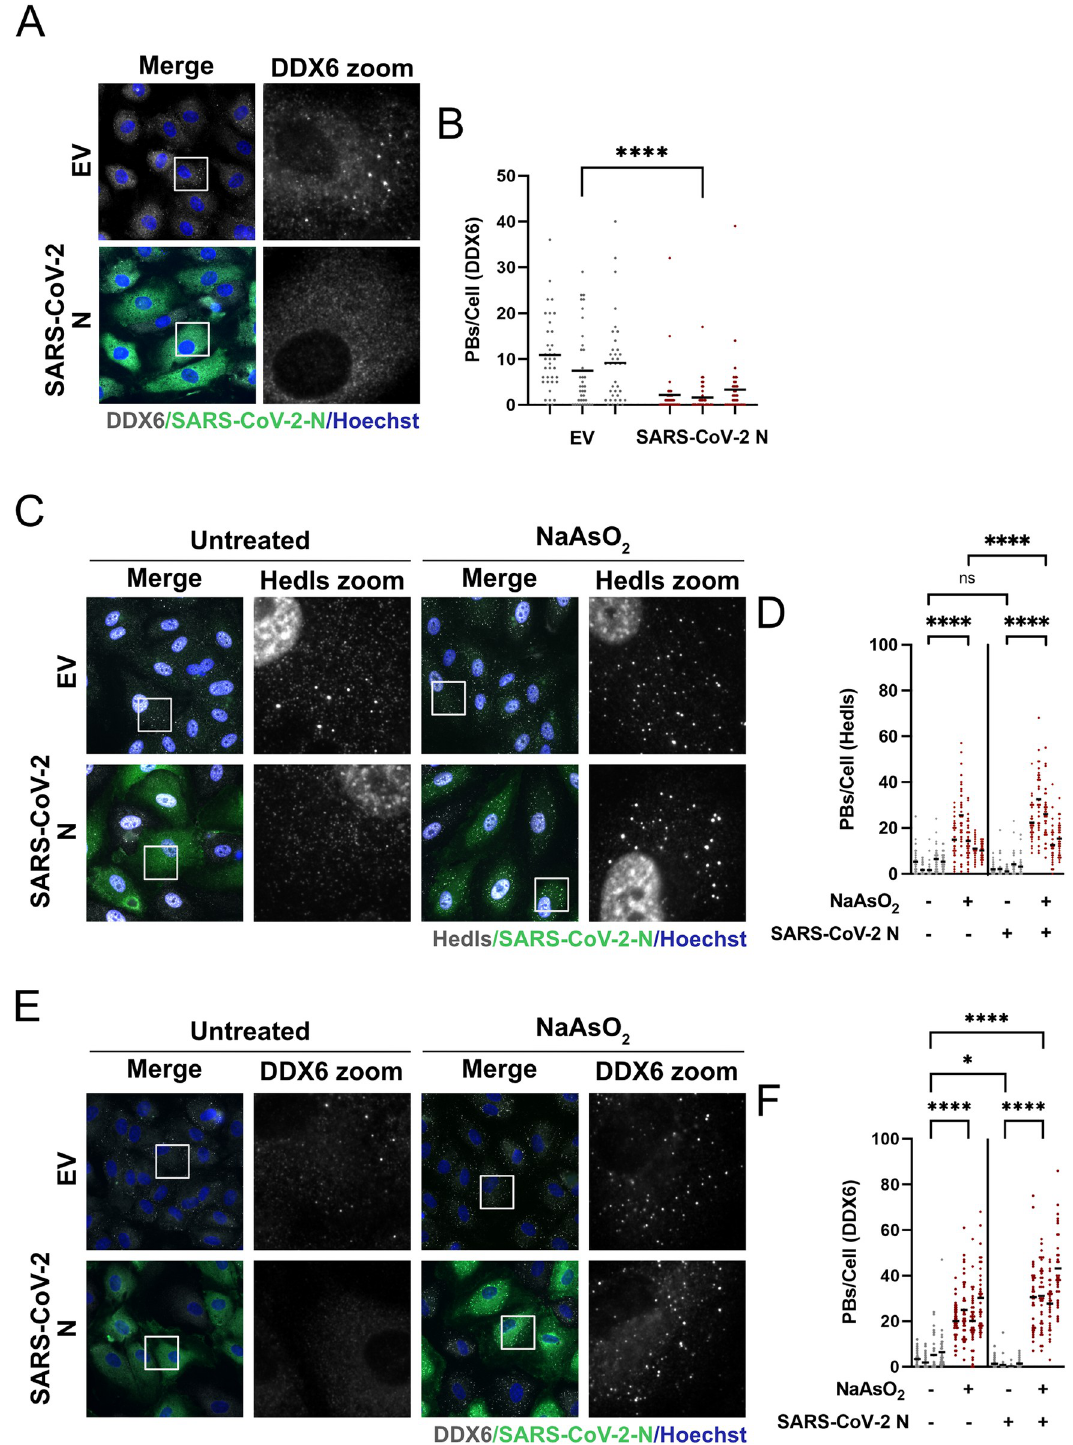
Fig 7. Ectopic expression of SARS-CoV-2 N elicits processing body disassembly. A-B. HUVECs were transduced with recombinant lentiviruses ectopically expressing 2X Strep-tagged SARS-CoV-2 N or empty vector control (EV) and selected with puromycin for 48 hours. Samples were fixed and immunostained for Strep-tag II (N; green) and DDX6 (PBs; white). Nuclei were stained with Hoechst (blue). Representative images from one of three independent experiments are shown ( n = 3 ). Scale bar = 20 μ m. DDX6 puncta were quantified per field of view using CellProfiler as in Fig 1. > 30 cells were measured per condition (EV and N) per